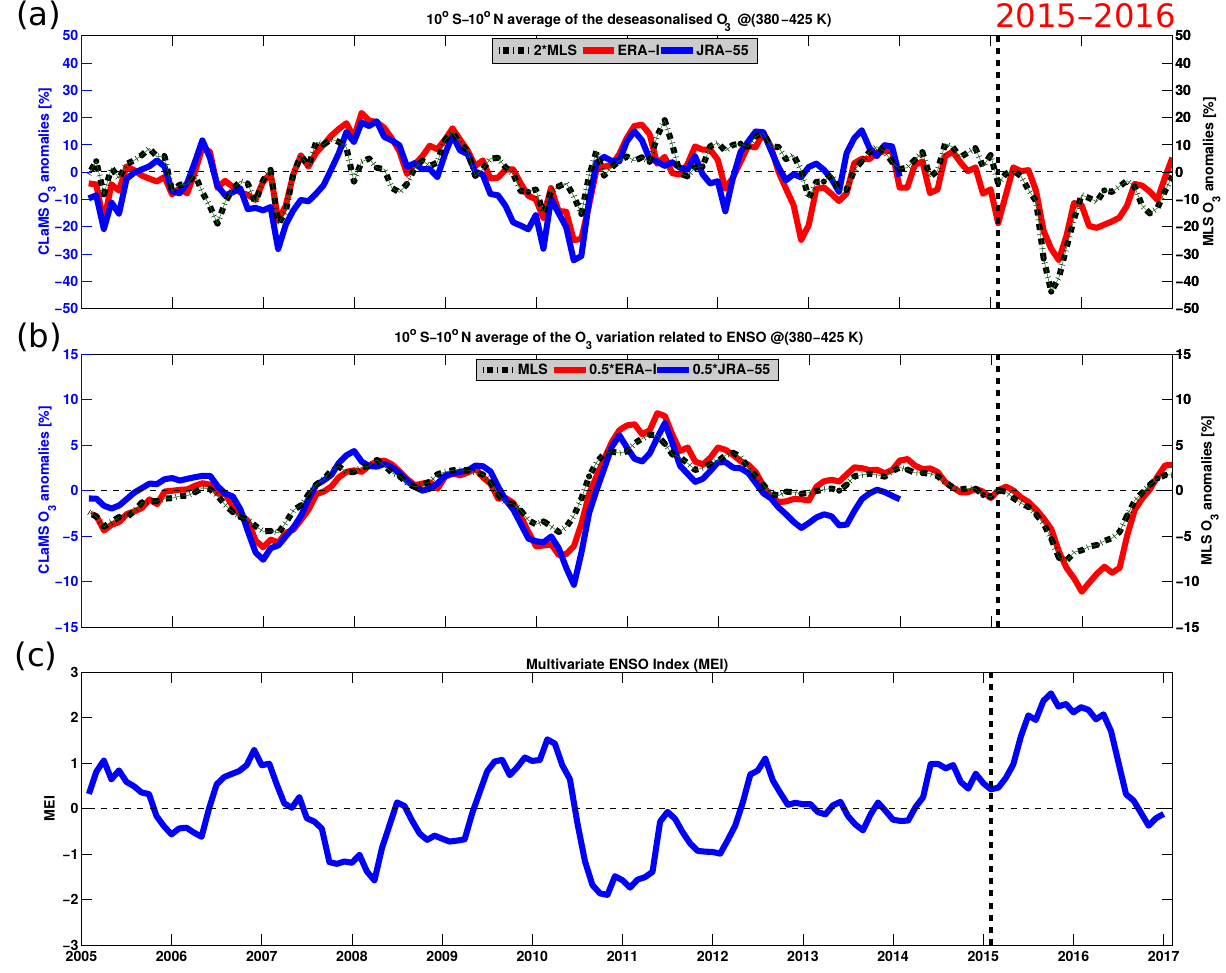
Figure 1. Time evolution of the tropical O 3 anomalies from CLaMS simulations sampled at the MLS measurement geolocations together with MLS satellite observations in percent change from the monthly zonal mean climatology and averaged between 380 and 425K for the 2005–2016 period. Panel (a) shows the 10 ◦ S–10 ◦ N deseasonalized O 3 for CLaMS driven by ERA-I (red); CLaMS driven by JRA-55 (blue) and MLS (dashed black). Panel (b) shows the ENSO-induced O 3 anomalies in the tropics for CLaMS driven by ERA-I (red); CLaMS driven by JRA-55 (blue) and MLS (dashed black) derived from the multiple regression fit. Panel (c) shows the Multivariate ENSO Index (MEI: blue). Note that there is a factor of 2 difference in the legend in (a) and (b) , reflecting the difference in the magnitude of the deseasonalized O 3 mixing ratio between CLaMS and MLS. Vertical black dashed line indicates February 2015 for the warm ENSO